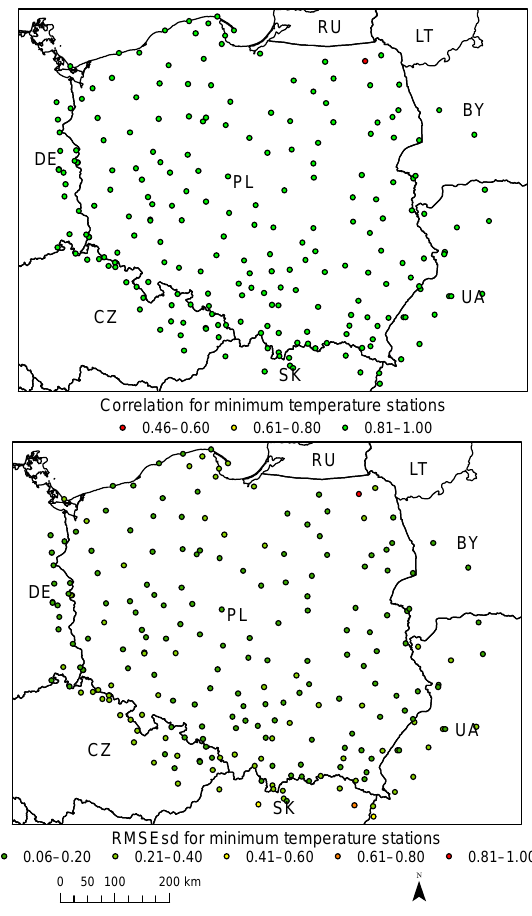
Figure 8. Minimum temperature ρ (top) and RMSEsd (bottom) val- ues calculated for stations in the period 1951–2013. National bor- ders (black lines) are labelled with country